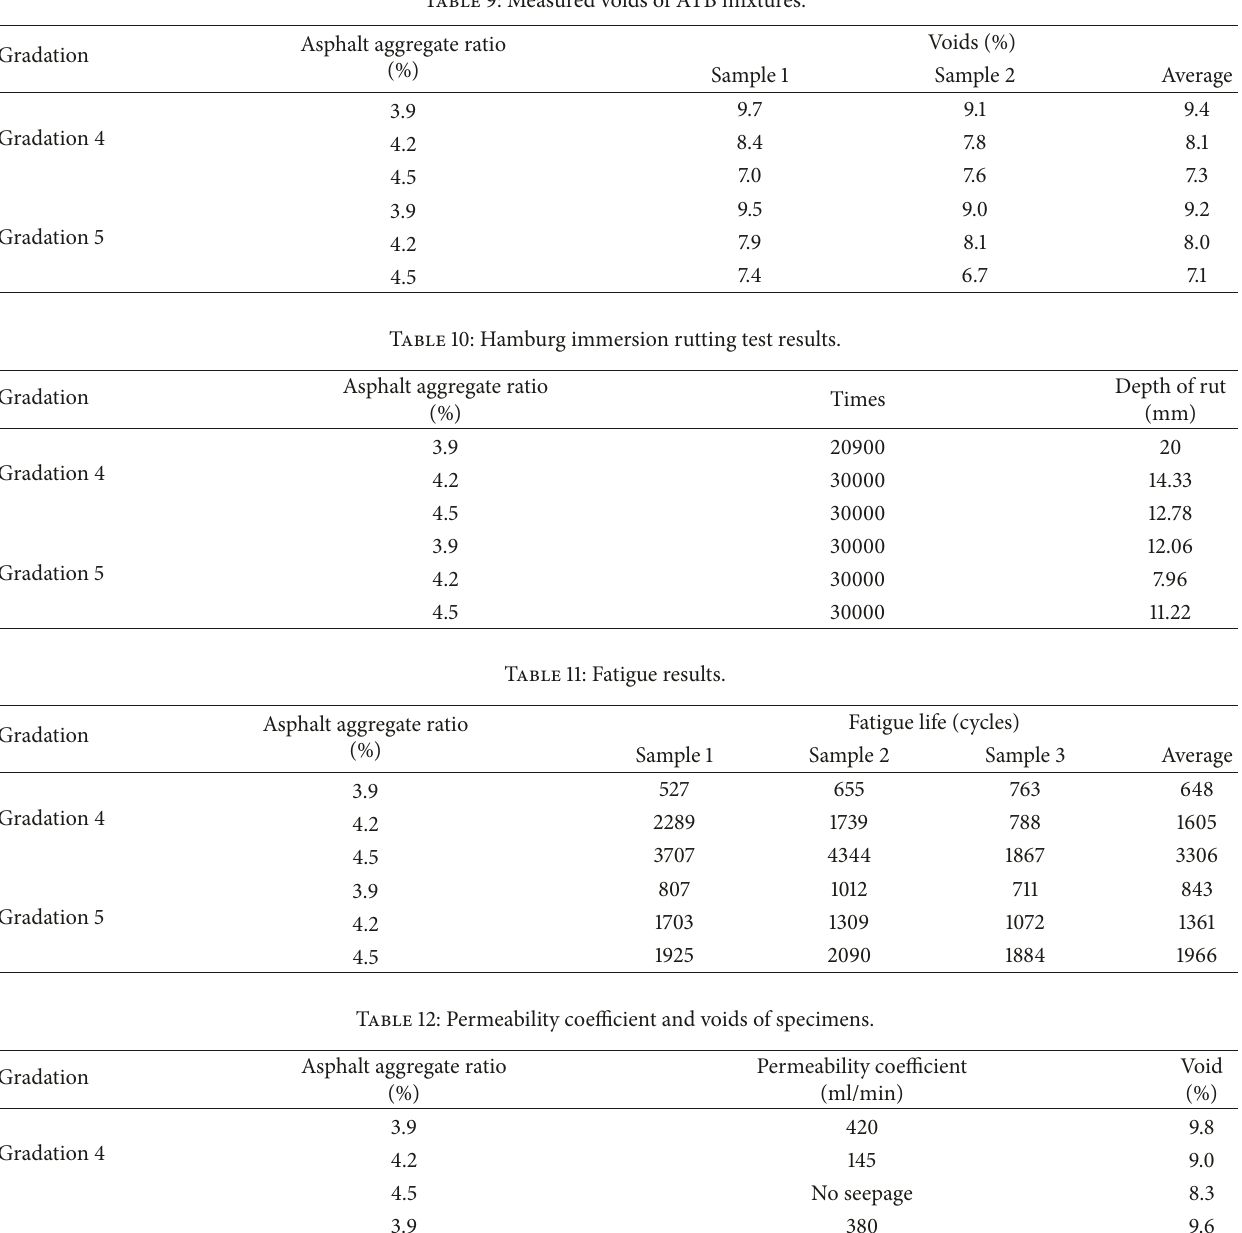
Table 9: Measured voids of ATB mixtures.